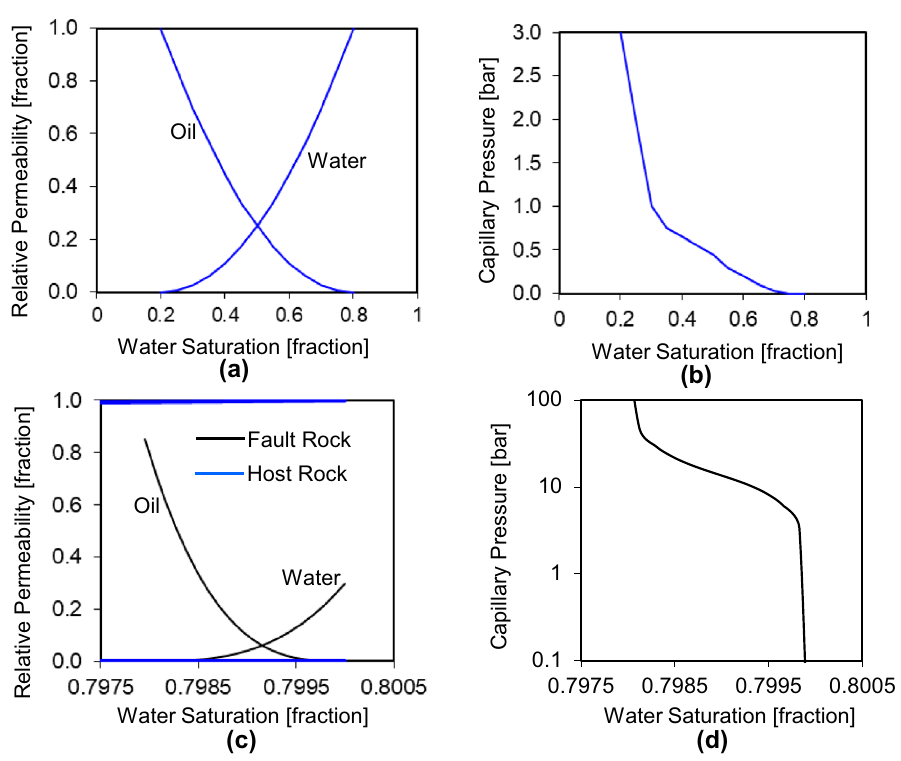
Figure 3. Input parameters of host rock and fault rock properties for the truth model. ( a ) The relative permeability and ( b ) the capillary pressure function of the host rock. ( c ) The relative permeability and ( d ) the capillary pressure curves of the fault